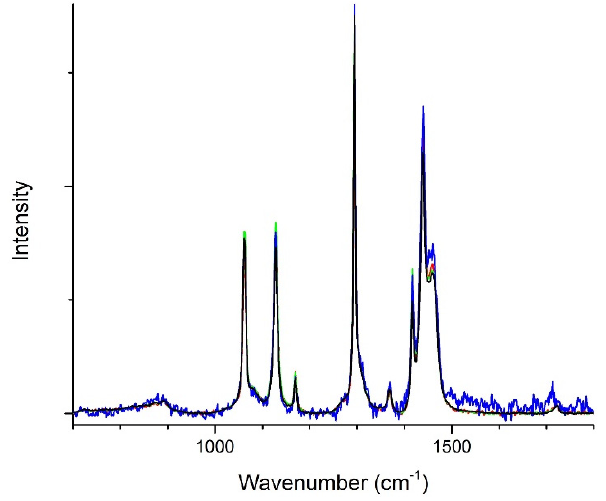
Figure 6. Baseline subtracted high-resolution Raman spectra showing the C ‒ C stretch, CH 2 twisting and CH 2 bending bands of gamma irradiated PE in fresh water (red trace), salt water (green trace), and Lake Michigan water (blue trace) showing minimal changes in comparison to the stock PE (black trace).